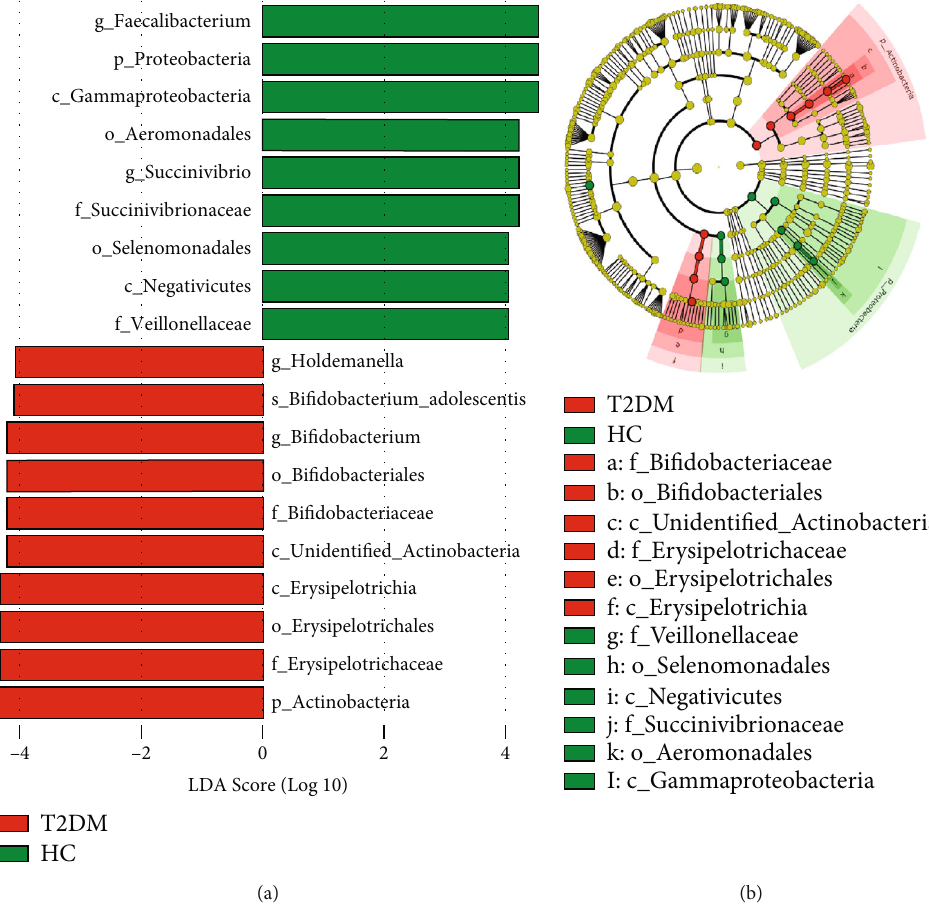
Figure 3: The LEfSe analysis fi ndings. (a) The most deferentially abundant taxa in HC ( n = 24 ) and T2DM ( n = 24 ) individuals have been analyzed using LEfSe (LDA e ff ect size software). Linear discriminant analysis (LDA) scores reveal the statistically signi fi cant biomarkers between the groups (biomarker with LDA score greater than the set value, the default setting is 4). (b) The taxonomy of the most deferentially abundant taxa. HC: healthy control; n : number; T2DM: type 2 diabetes